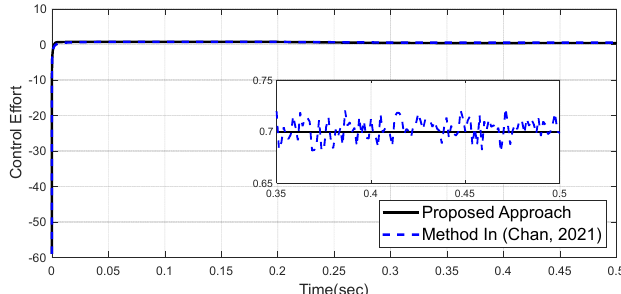
Figure 8. Controller effort signals [1] .